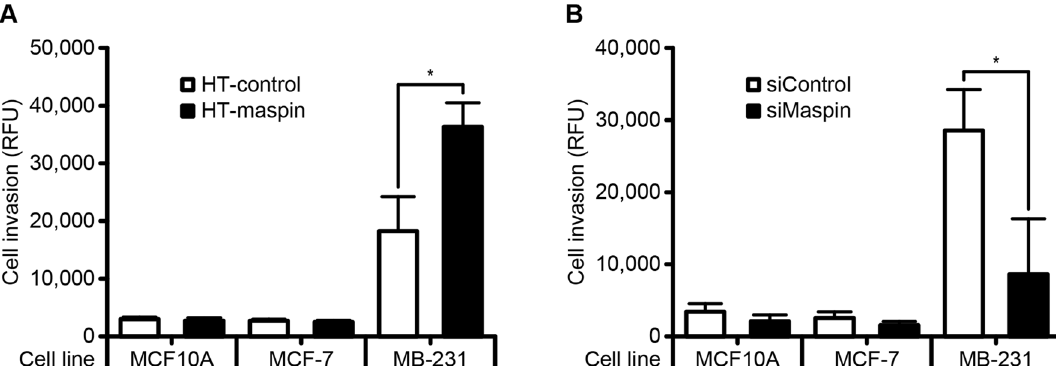
Figure 3. The relevance of maspin expression and subcellular localization to cell invasion. ( A ) Cell invasion capability of cells overexpressing HaloTag-fused maspin or HaloTag-control. Data are shown as the mean ± SD ( n = 3). * P < 0.05; Student’s t -test. ( B ) Cell invasion capability of cells expressing maspin siRNA or control siRNA. Data are shown as the mean ± SD ( n = 3). * P < 0.05; Student’s t -test.